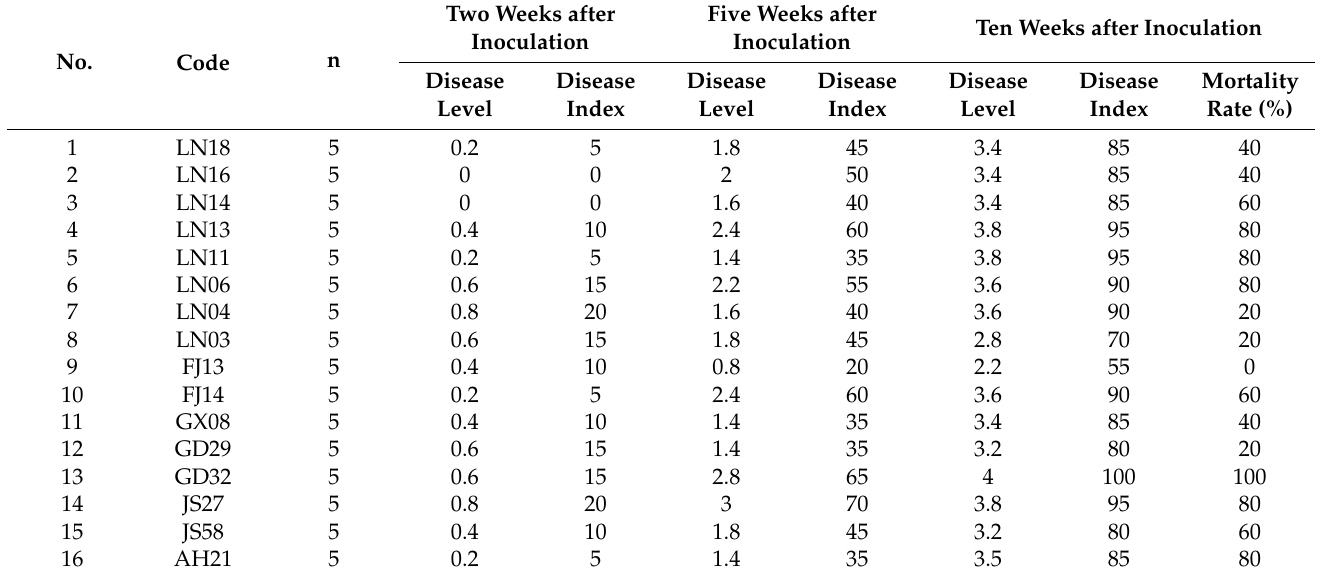
Table 6. The disease level and index and the mortality rate of P. tabuliformis after artificial inoculation with southern and northern PWN strains.